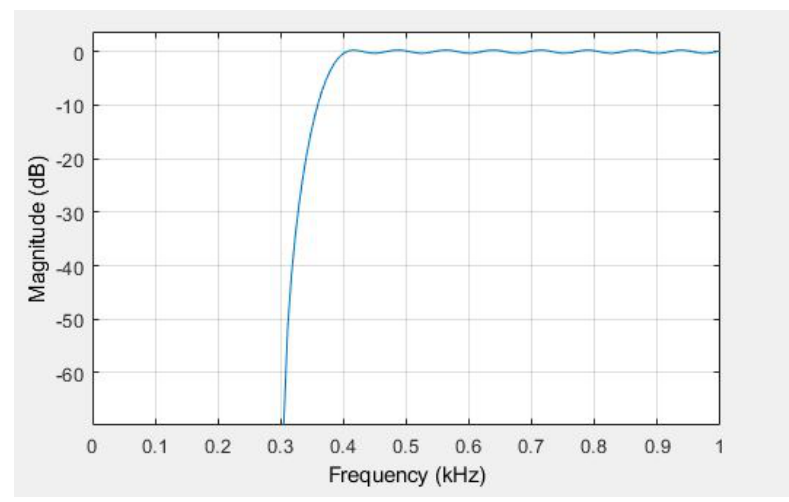
Figure 2. Frequency response of the neural signal FIR